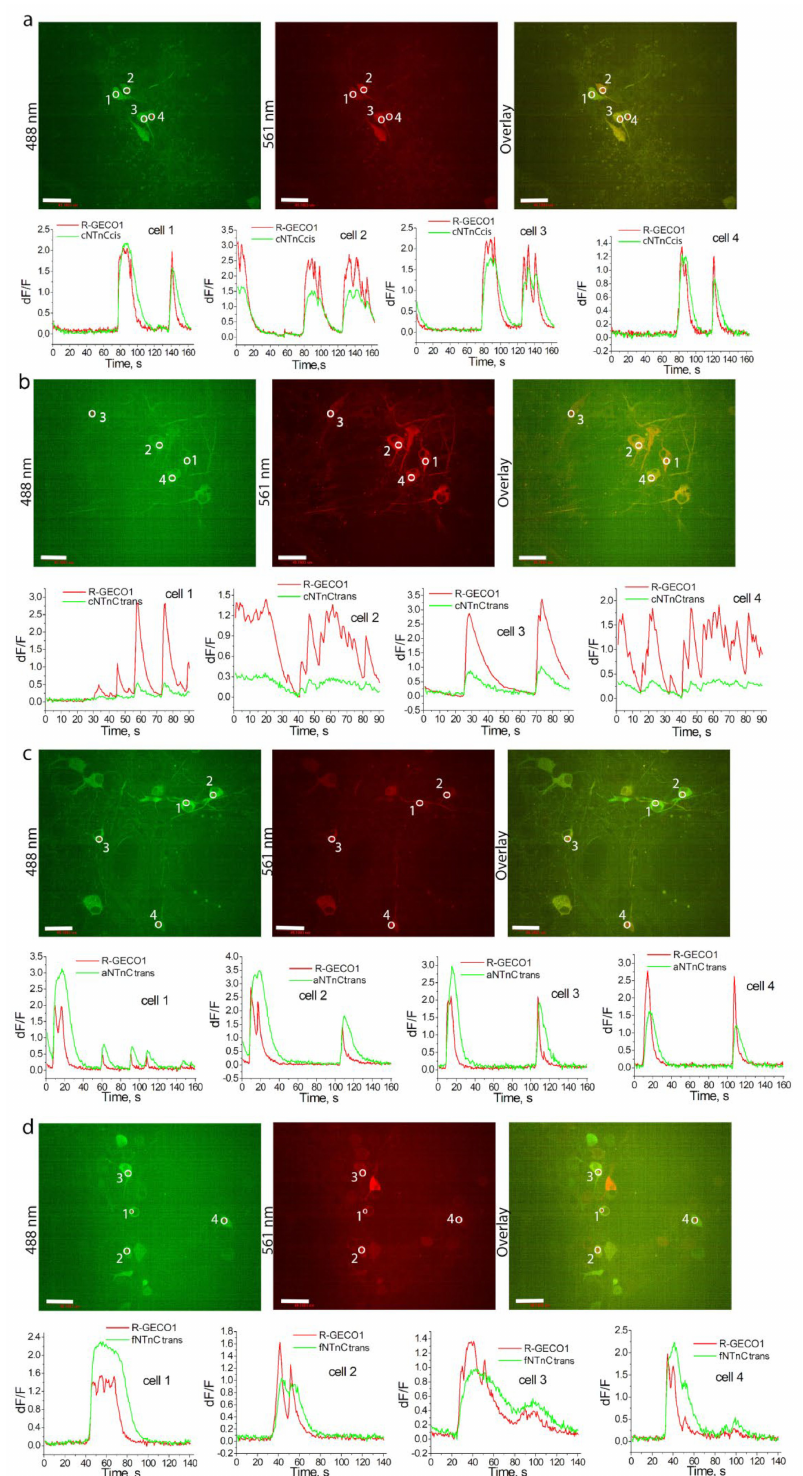
Figure 4. Spontaneous neuronal activity of NTnC-like variants with truncated troponin C from hummingbird ( a , b ), cheetah ( c ), and falcon ( d ) coexpressed with R-GECO1 in neuronal cultures. Top, confocal images of HeLa cells coexpressing green GECIs with red R-GECO1 indicator in green and red fluorescence channels (excitation at 488 and 561 nm, respectively) and their overlay. Bottom, the graphs for each mutant show the changes in green and red fluorescence for four cells in the areas indicated with white circles. Scale bars, 50 µ